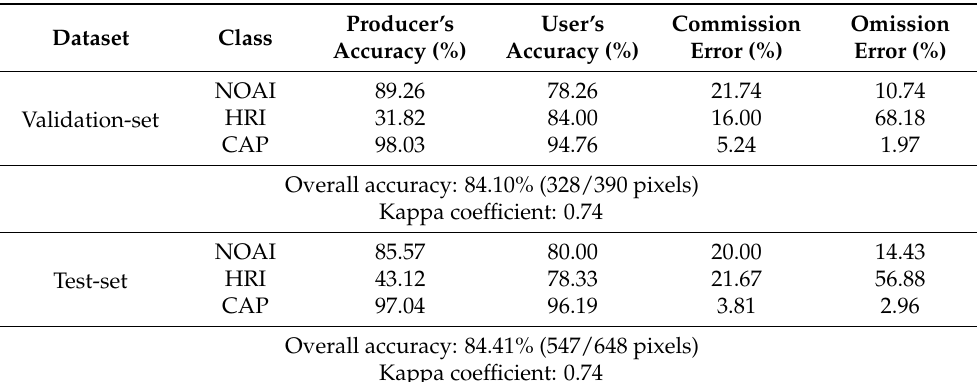
Table 6. Confusion matrix of the validation and test dataset for NOAI, HRI, and CAP classification models applied to 2018